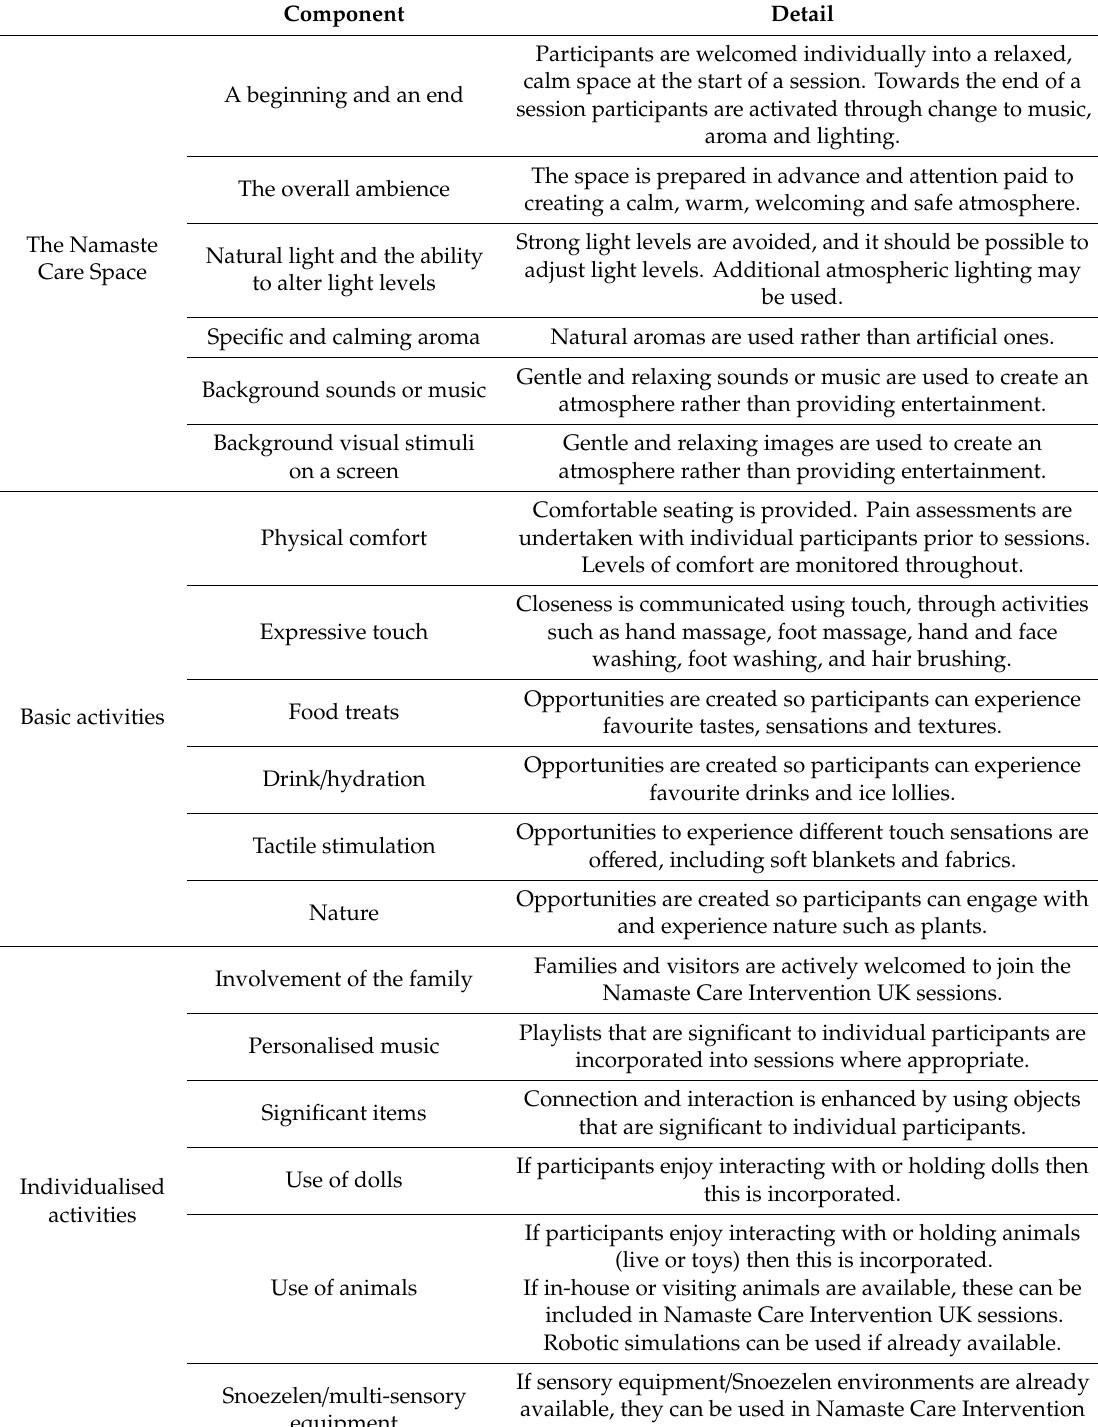
Table 1. Key Components of the Namaste Care Intervention